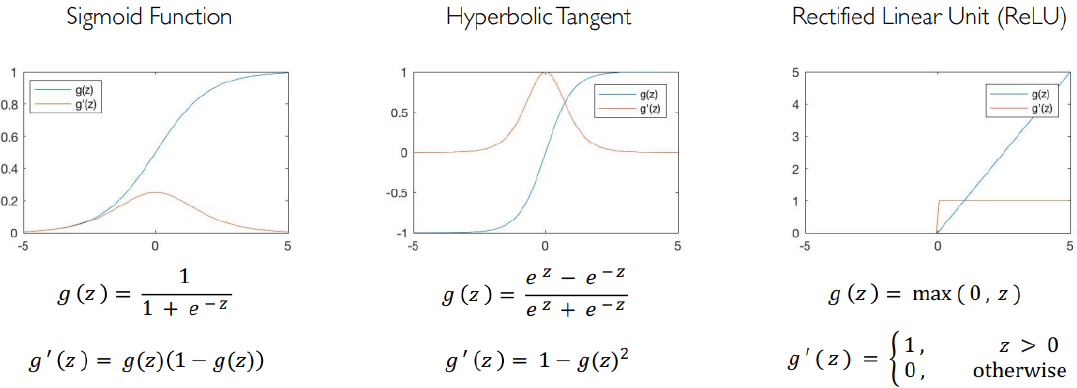
Figure 3. Common activation